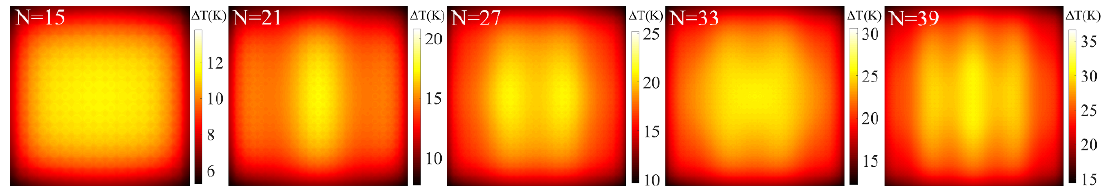
Figure 13. Temperature distribution under the effect of plasmonic coupling.